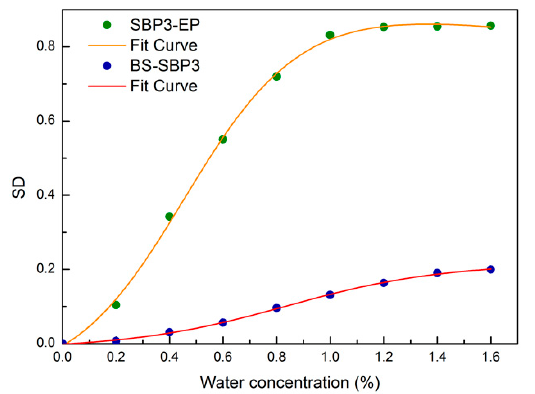
Figure 7. The spectral distance behavior as a function of water content concentration for the intramolecular OH-stretching bands of BS-SBP3 (blue circles) and EPS-SBP3 (green circles); fitting continuous curves for BS-SBP3 and EPS-SBP3 are shown in red and orange, respectively.